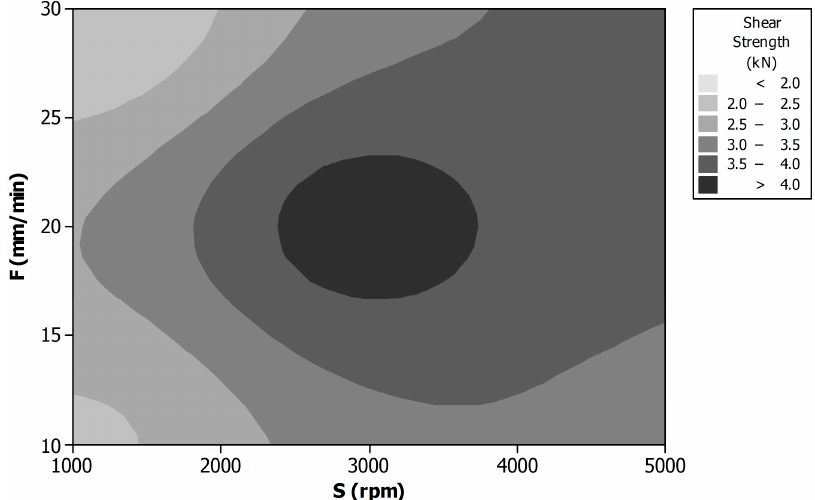
Figure 6. Contour plot of shear strength vs. tool rotational speed (S) and feed rate (F).